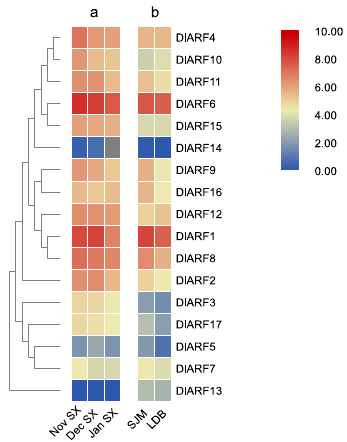
Figure 6. Expression analysis of DlARF genes from different varieties. ( a ): expression of DlARFs in apical buds of ‘Shixia’ from November to January of the following year; ( b ): expression of DlARFs in the buds of the ‘Lidongben’ and ‘Sijimi’. Note: SX is Shixia, SJM is Sijimi, LDB is lidongben.